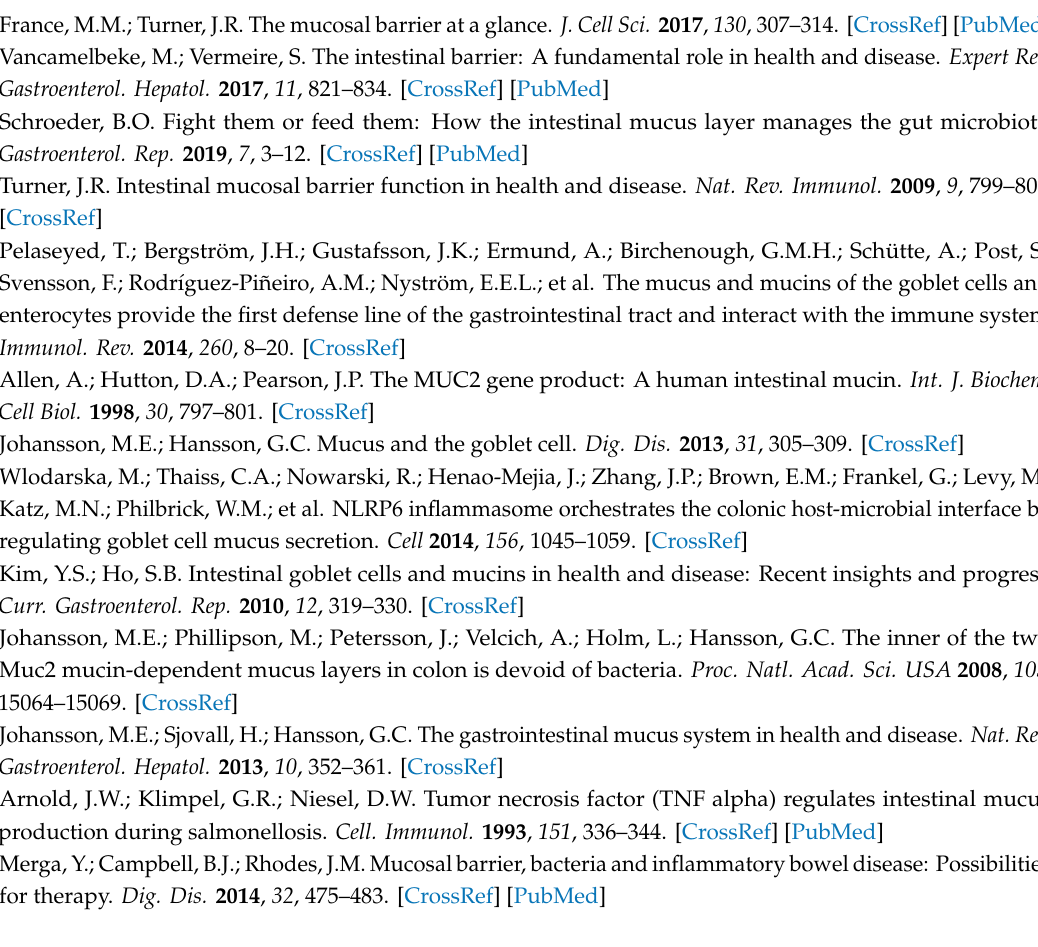
Table S1: The mental and physical health-related quality of life data of the included subjects using SF-12 questionnaire ( n = 159); Figure S1: Statistical output of all analyses. Appendix: The Stata output of all